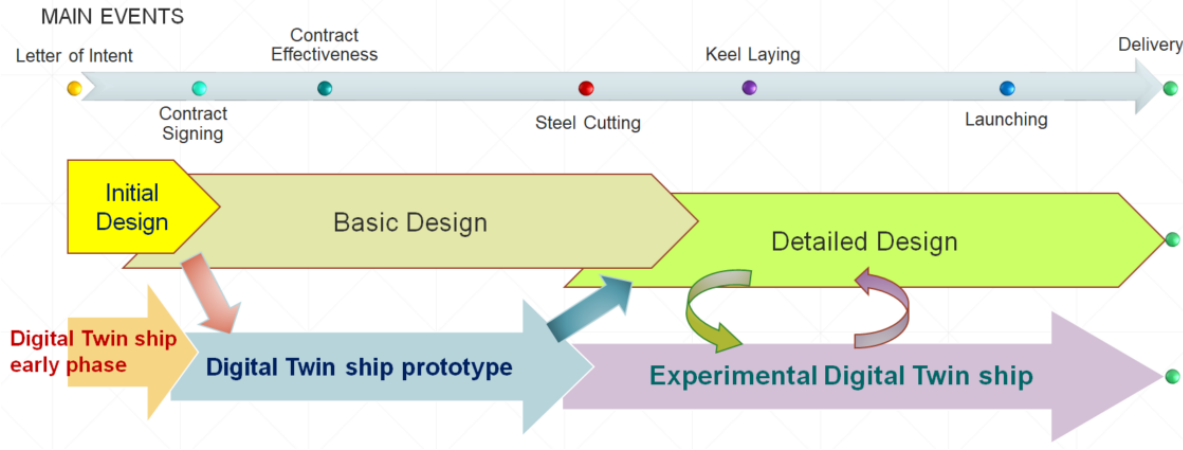
Figure 7. Digital Twin development phases.